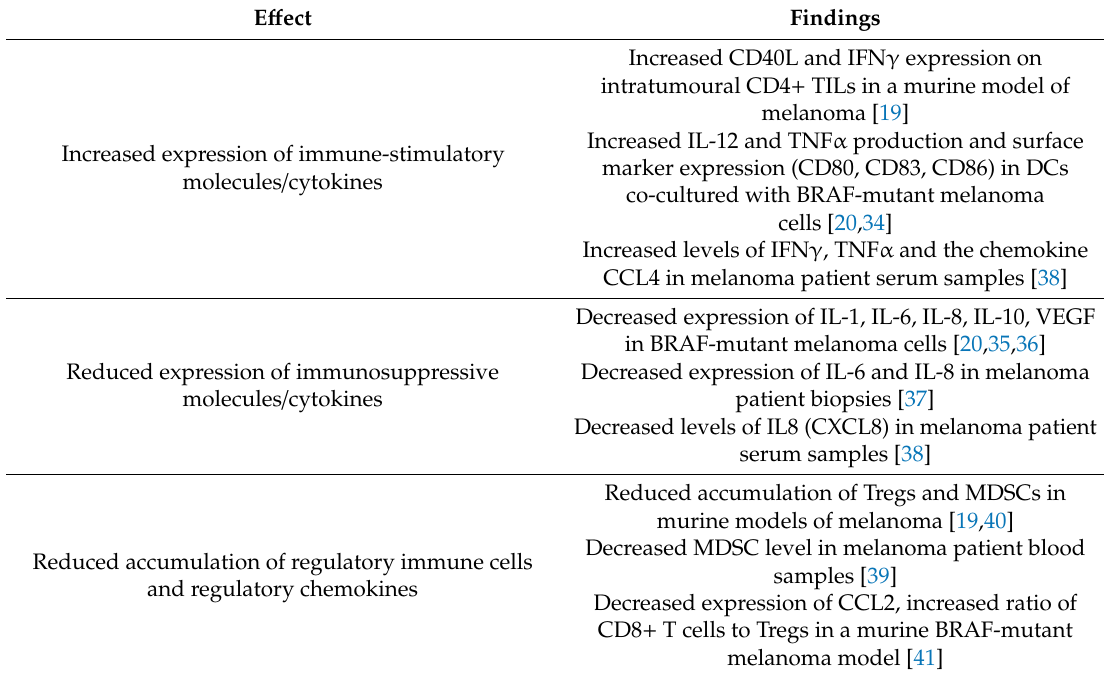
Table 2. Mechanisms by which BRAF Inhibitors Help Restore an Immune-stimulatory